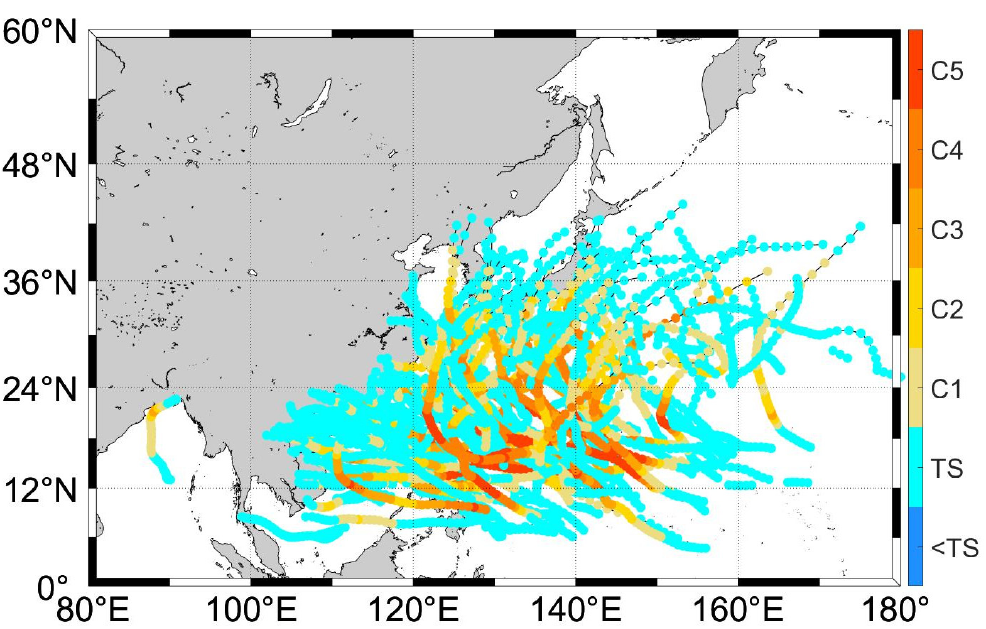
Figure 1. Intensities (referring to different color shadings) and central positions of all typhoon cases (in 3 h intervals) used in this study.